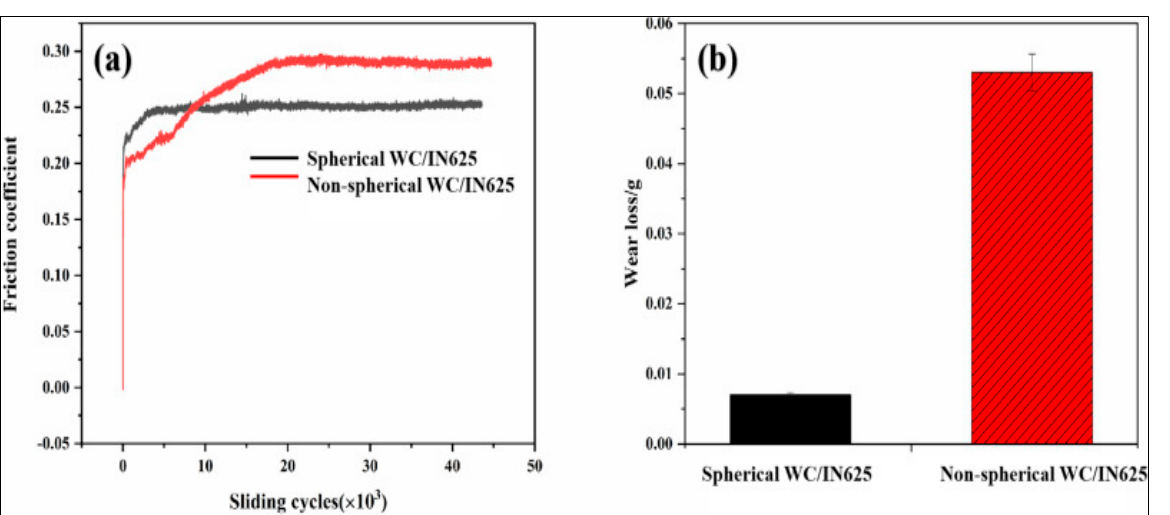
Figure 20. E ff ect of WC reinforcement shape on ( a ) friction coe ffi cient; ( b ) mass loss (adapted with Figure 20. Effect of WC reinforcement shape on ( a ) friction coefficient; ( b ) mass loss (adapted with permission from Ref. [65] 2022, Elsevier). permission from Ref. [65] 2022,